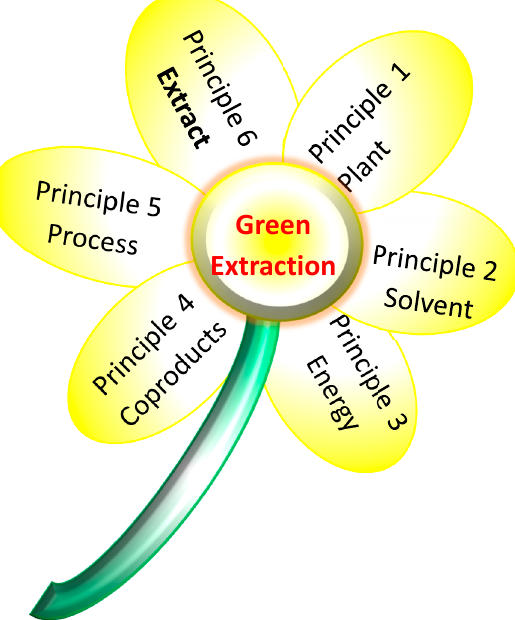
Figure 2. Green process assessment according to green extraction. Principle 1: Innovation by selection of varieties and use of renewable plant resources. Principle 2: Use of alternative solvents and principally water or agro-solvents. Principle 3: Reduce energy consumption by energy recovery and using innovative technologies. Principle 4: Production of co-products instead of waste to include the bio- and agro-refining industry. Principle 5: Reduce unit operations and favor safe, robust, and controlled processes. Principle 6: Aim for a non-denatured and biodegradable extract without